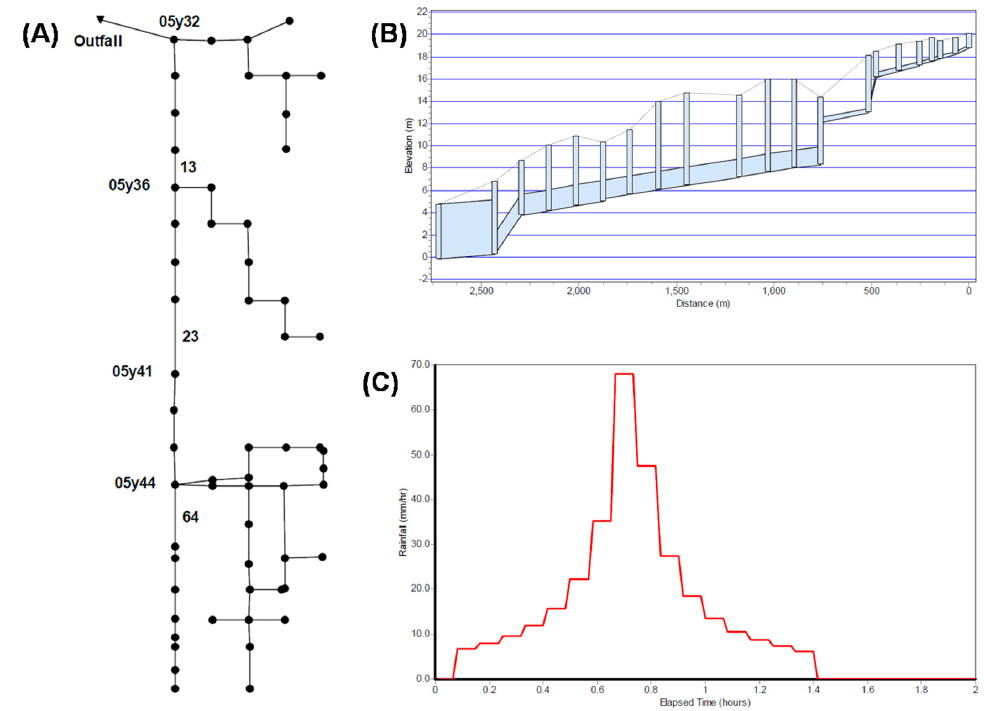
Figure 5. ( A ) Schematic of the case study drainage network. ( B ) Elevation profile of the main stem of the case study drainage network. ( C ) Rainfall hyetograph for the design storm used for the case study drainage network. The figures are cited from [39].